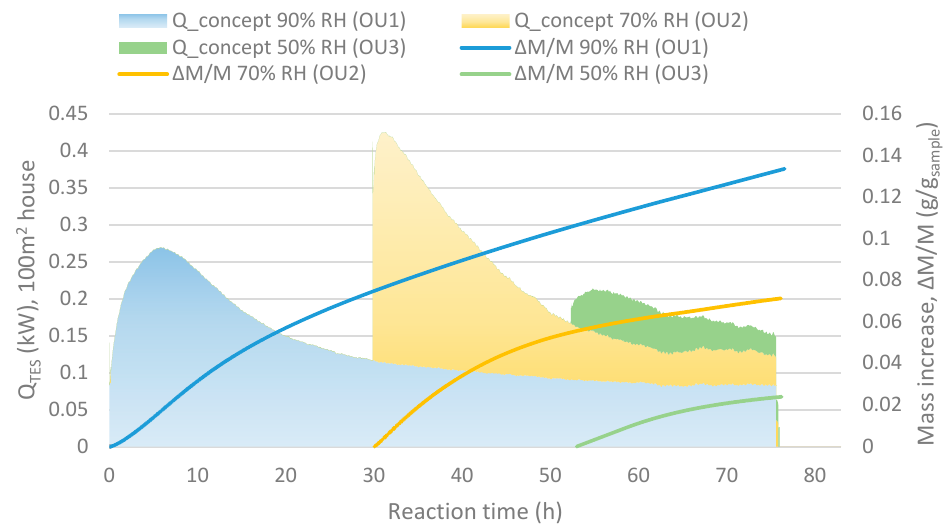
Figure 7. Schematic graph over the operating units (OU) connected in serial and the relative humidity (RH) of the inlets/outlets.